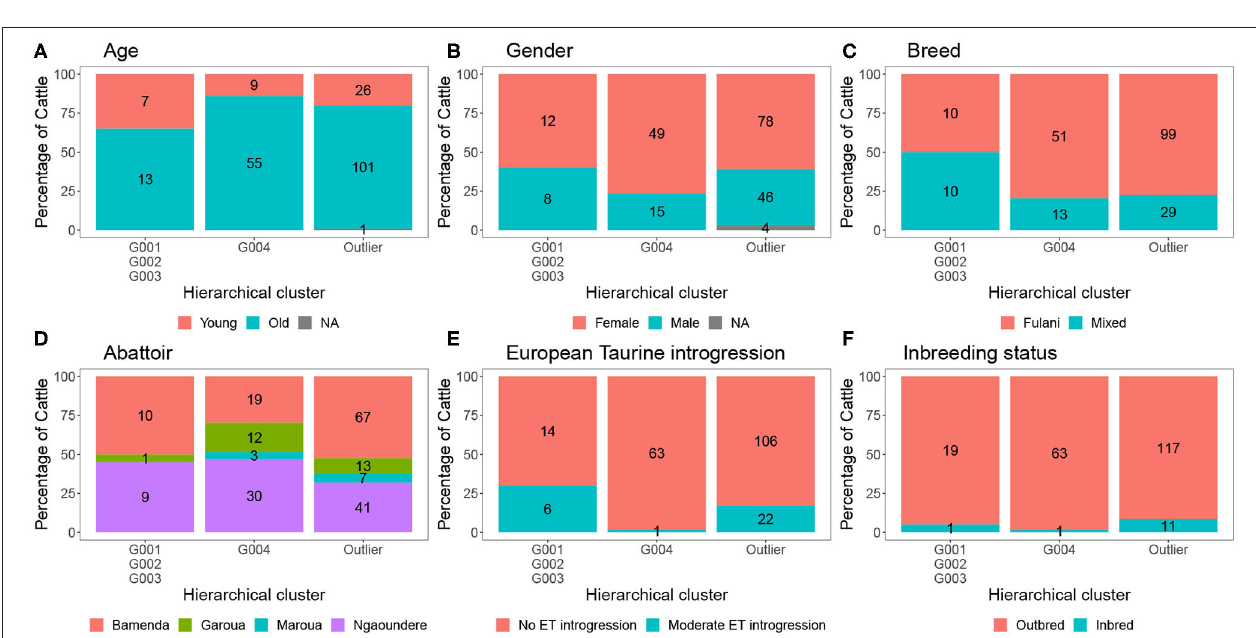
FIGURE 9 | The number and percentage of animals in each hierarchical cluster according to (A) age, (B) gender, (C) local abattoir employees definition of breed, (D) abattoir, (E) European taurine introgression, and (F) inbreeding status. The labels refer to number of individuals belong to each group.